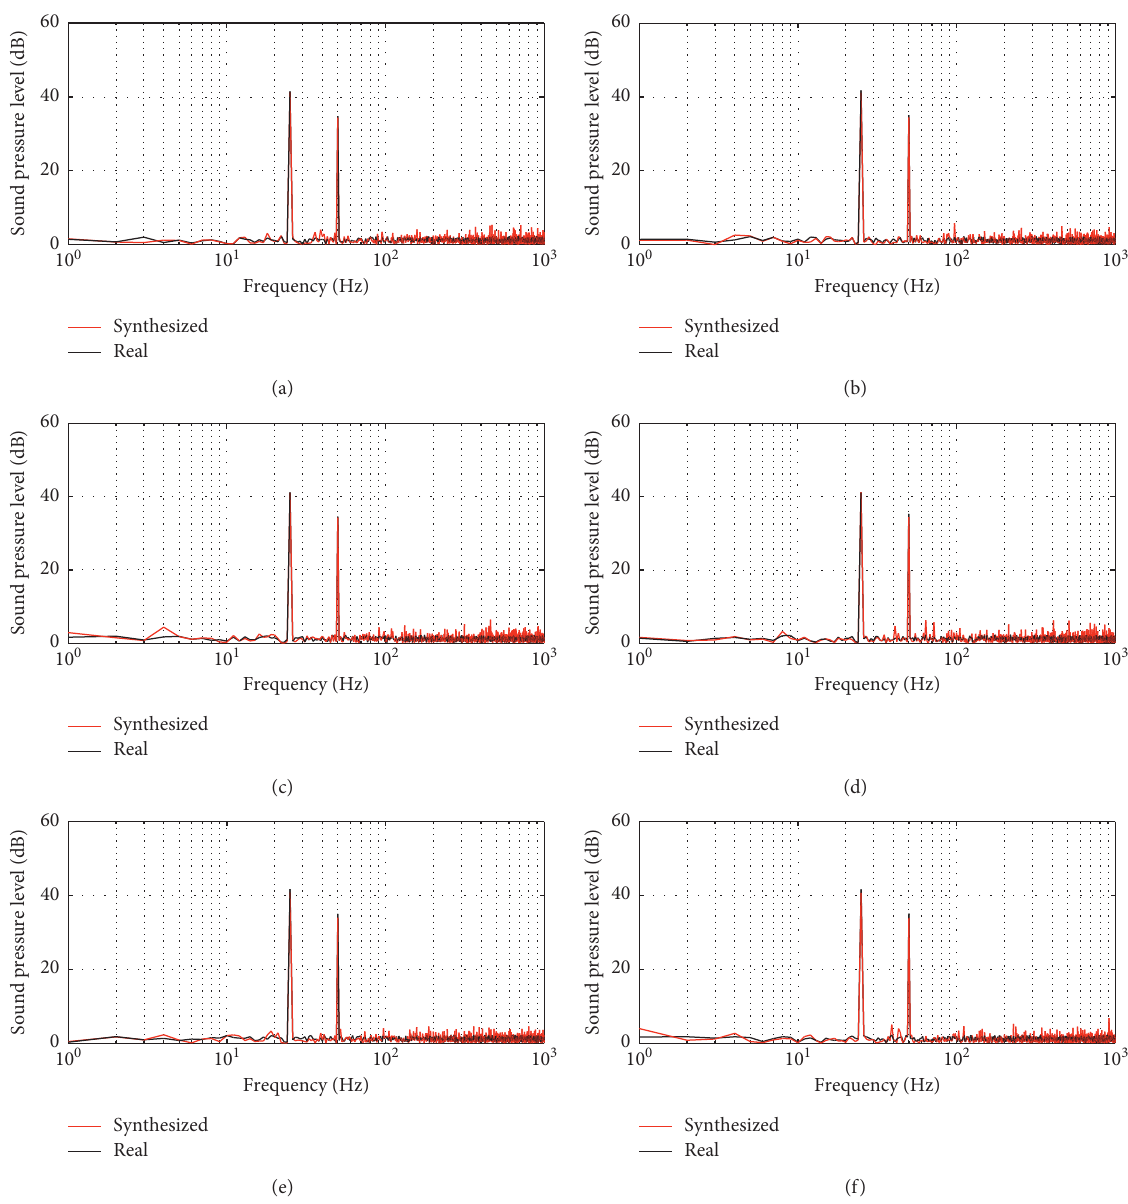
Figure 8: Spectrum of the numerical study for the 6 corresponding blocks: (a) measurement block 1; (b) measurement block 2; (c) measurement block 3; (d) measurement block 4; (e) measurement block 5; (f) measurement block